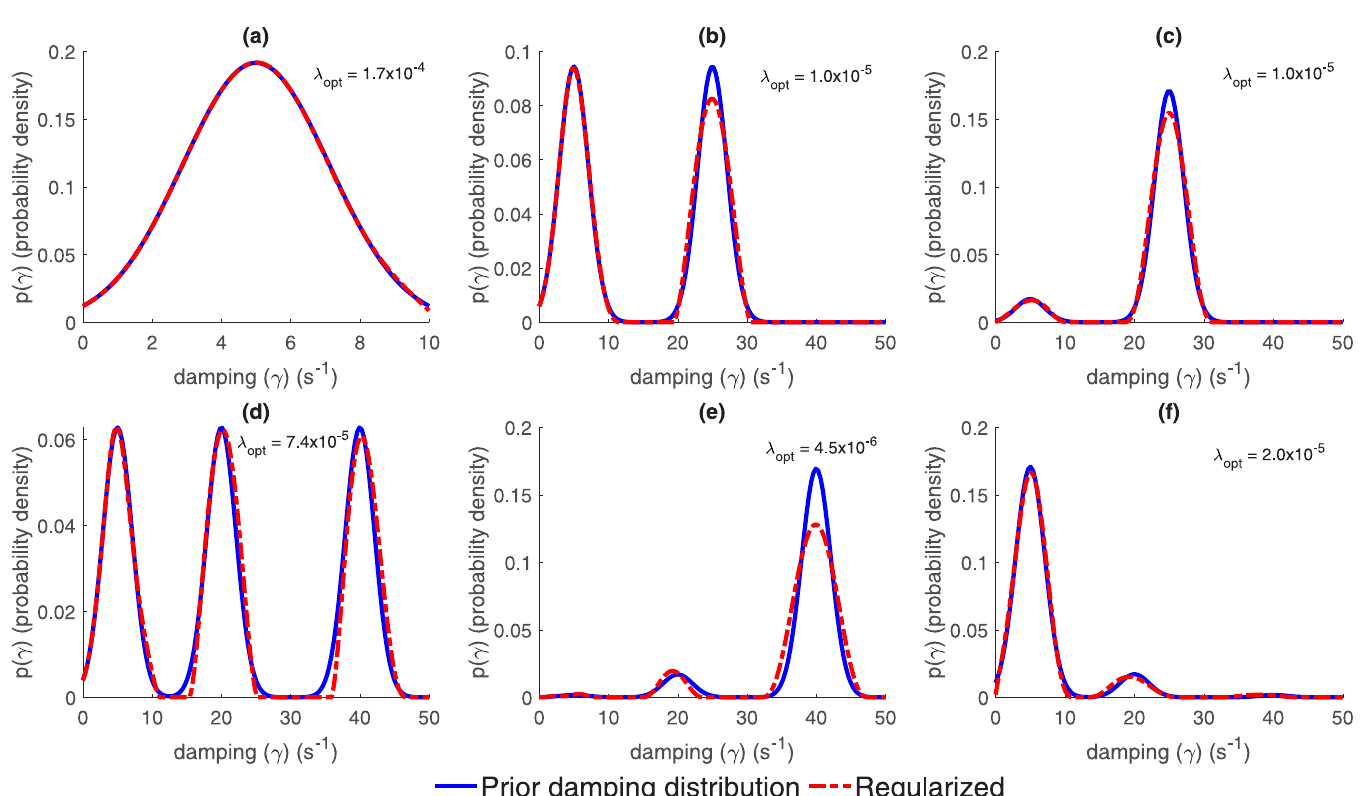
Fig 2. Validation of the inverse method by the recovery of prior damping distributions. (a) Unimodal prior damping distribution. (b ) Bimodal prior damping distribution where both modes of same peak magnitude (c) Bimodal prior damping distribution where the relative magnitude of the peak of the most weakly damped mode is 0.1 that of the peak of the heavier damped mode. (d) Trimodal prior damping distribution where all modes are of the same peak magnitude. (e) As for (d) but relative peak mode heights are 0.01, 0.1 and 1 respectively. (f) As for (d) but relative peak mode heights are 1, 0.1 and 0.01 respectively. Blue lines are the prior distributions, whereas red dotted lines represent the recovered distributions using the inverse Tikhonov regularisation method and λ opt are the optimally chosen regularisation parameters. For further details refer to Methods.